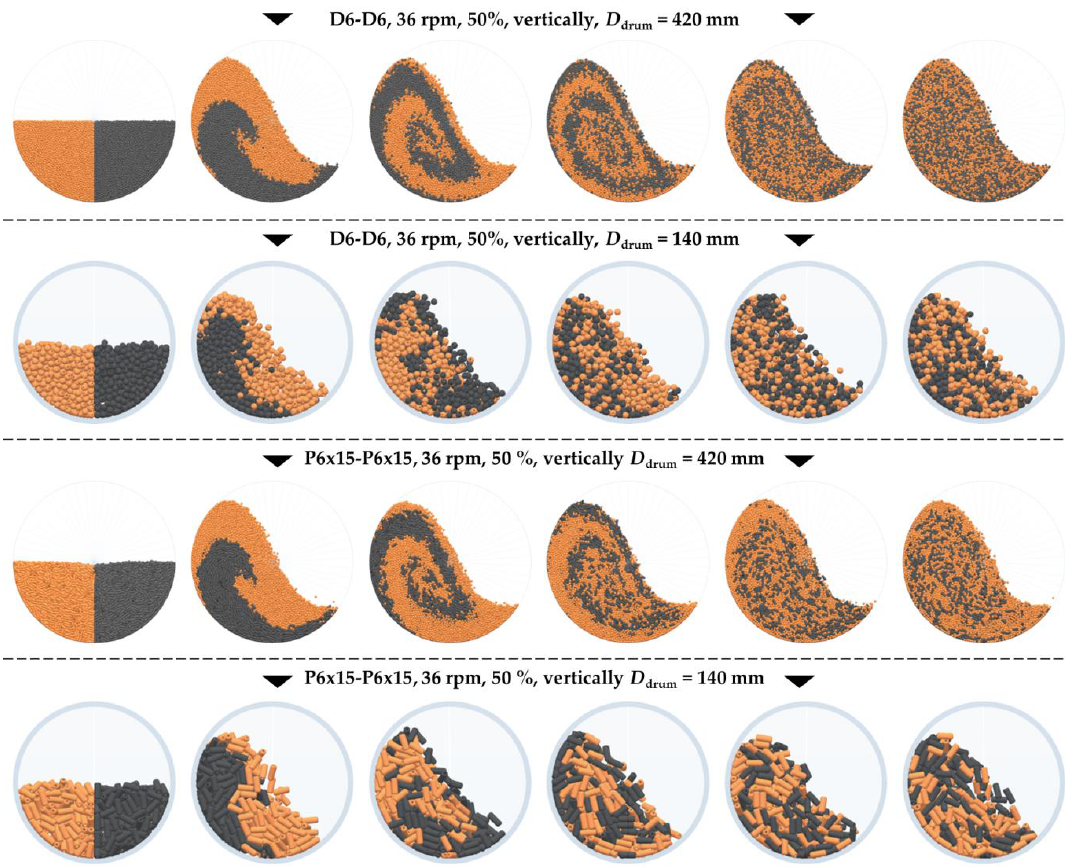
Figure 16. A graphic comparison of mixing in drums of different diameters after 0 to 5 revolutions.